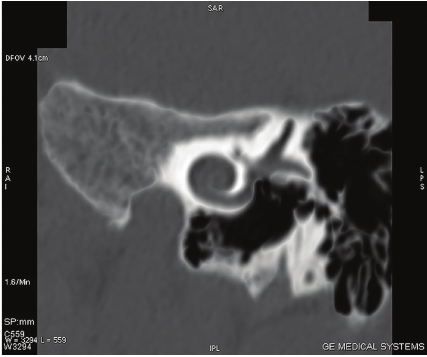
Figure 1: HRCT scan of temporal bone with coronal section showing cochlear anomaly in which cochlea shows 1 and 1 / 2